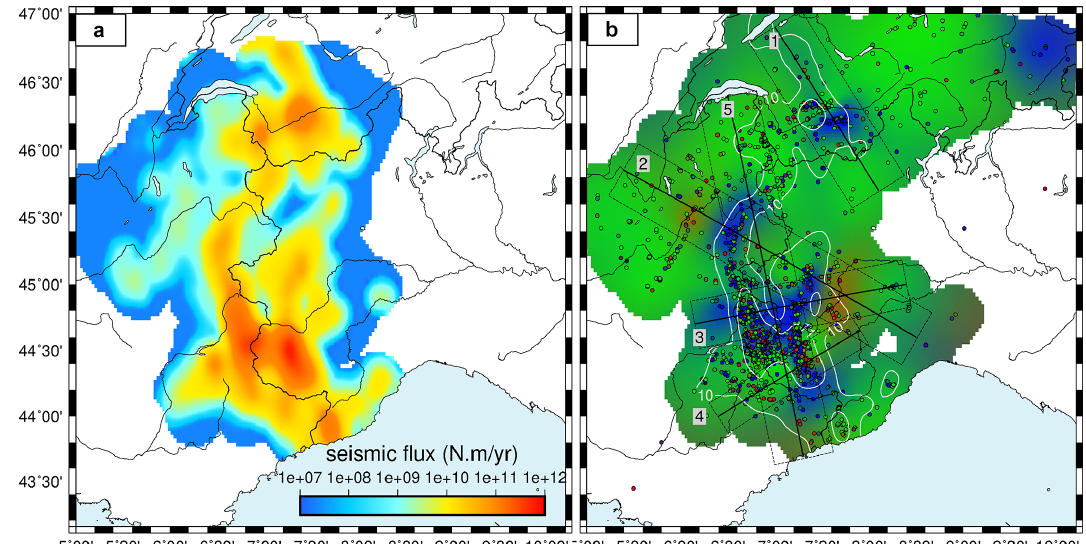
Figure 7. (a) Seismic flux computed using the annualized seismic moment ( M o ) over the 1989–2014 time interval, summed in 0.05 ◦ × 0.05 ◦ cells and interpolated with an adjustable tension curvature surface algorithm (Smith and Wessel, 1990). Areas without focal mechanisms within 35km are masked out, as well as mechanisms in the Ligurian Sea and in NE Switzerland, due to the lack of constraints. (b) Mean values of the distributions of P , T , and B axis plunges resulting from a Bayesian inversion. The colour code is according to the Kaverina classification of the style of deformation (the end-members red, blue, and green corresponding to reverse, normal, and strike-slip deformation styles, respectively). Focal mechanisms used are represented as dots filled with the same colour code. Areas without focal mechanisms within 35km are masked out, as are mechanisms in the Ligurian Sea, due to the lack of constraints. White lines show isocontours of the seismic flux from (a) in log 10 (M o ) . Profiles numbered from 1 to 5 correspond to the interpolated vertical cross sections in Fig. 9. Dashed boxes encompass the focal mechanisms projected along each profile in Fig. 9.